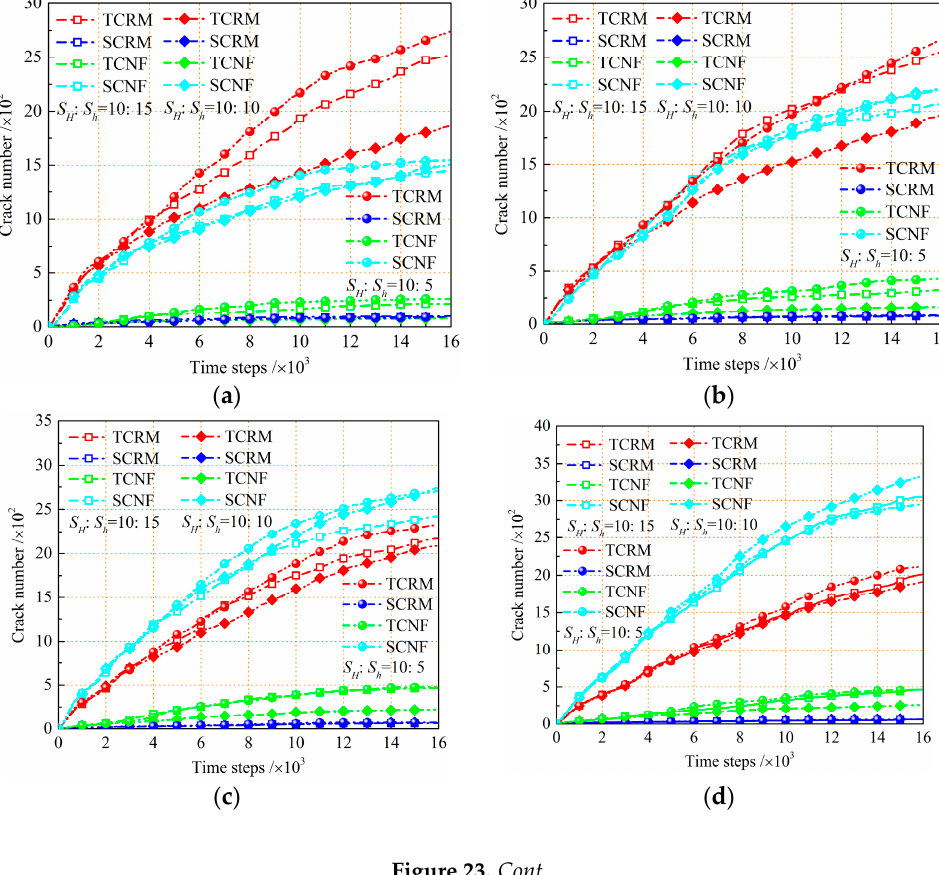
Figure 22. Change of crack distribution with confining pressure ratio when NF density ranges from 24/m to 72/m and injection rate is 2.0 × 10 − 6 m 3